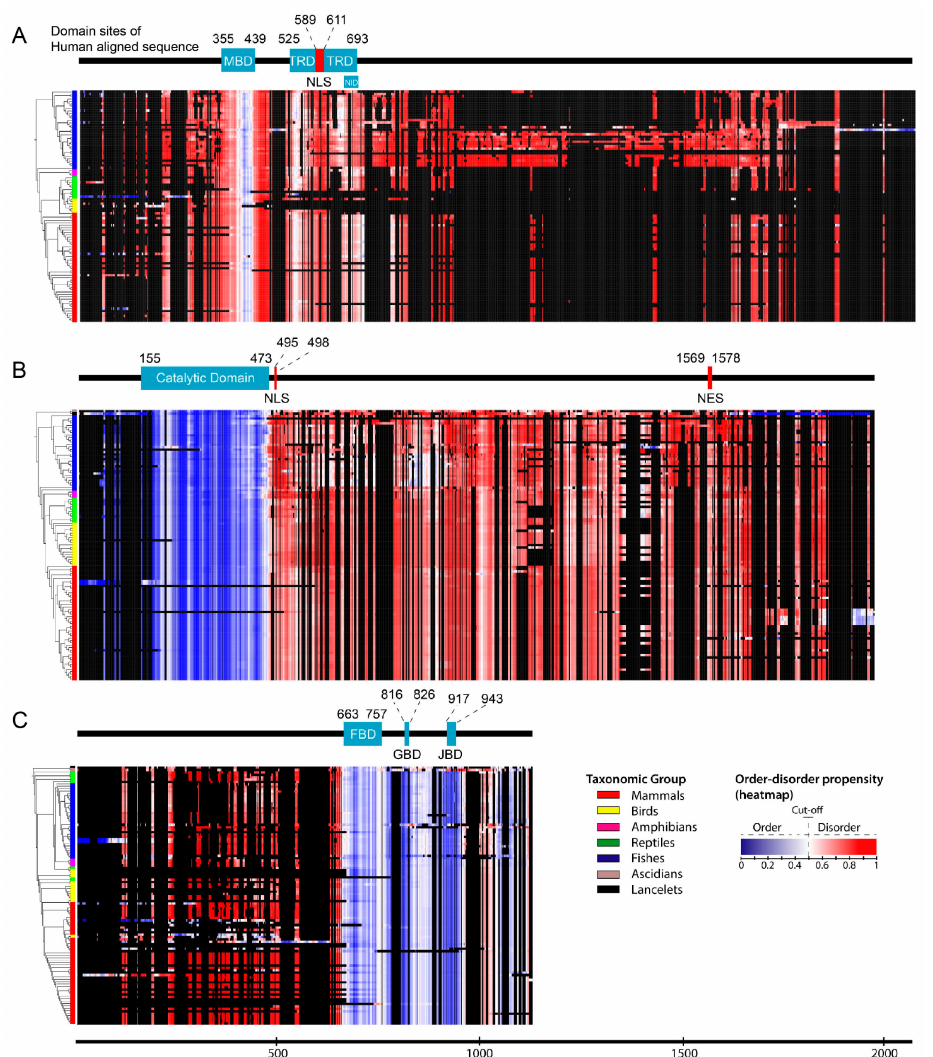
Figure 1. The order–disorder propensity of RTT and RTT-like causing proteins in chordates. Heat maps of the order–disorder propensity were generated according to the taxonomic positions in the phylogenetic tree (rows) and multiple sequence alignment (columns). The heat maps show a color gradient of blue (ordered) to red (disordered), with white as the boundary between the two and black as gaps. Colored boxes between the trees and heat maps indicate the taxonomic group, and bars above the heat maps indicate domain position in the multiple sequence alignment, with light blue and black areas indicating the domain and absence of a domain, respectively. ( A – C ) Heat maps for MeCP2 ( A ), CDKL5 ( B ), and FOXG1 ( C ) are shown. MBD, TRD, NID, FBD, GBD, JBD, NLS, and NES